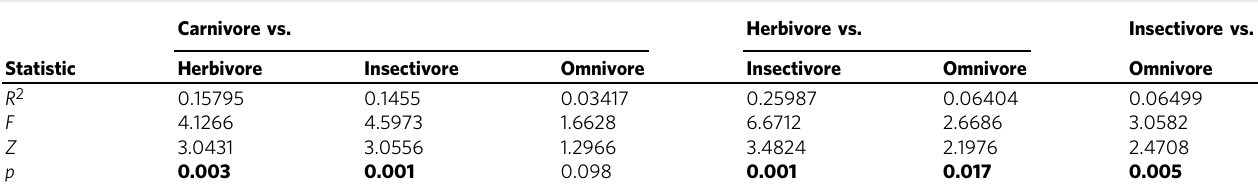
Table 2 Summary of the Procrustes ANOVA (Type II, Conditional SS) performed for jaw shape data as a function of dietary group. Carnivore vs. Herbivore vs. Insectivore